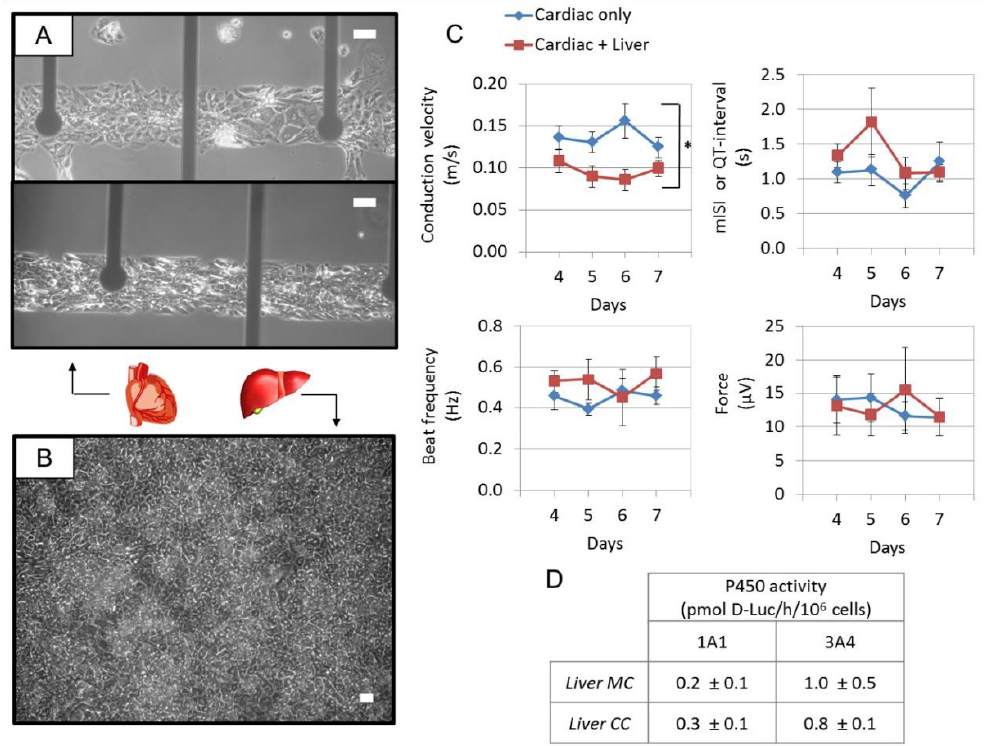
Figure 5. Characterization of the heart–liver system—serum-free and flow—with non-invasive measurements for seven days. Human cardiomyocytes and hepatocytes were studied over seven days in HSL3 medium. Representative morphology images are shown for human cardiomyocytes ( A ) in mono-culture (top) or co-culture (bottom) (80 µ m scale) and hepatocytes in co-culture ( B ) after seven days in the housing (50 µ m scale). Cardiac function was measured over seven days in the presence (red square) or absence (blue diamond) of hepatocytes. Cardiac function is plotted as conduction velocity, spontaneous beat frequency, mISI (or QT interval), and contractile force ( C ). Two-way ANOVA was performed to study the effects of culture time and the presence of the hepatocytes on the different cardiac functional parameters; conduction velocity (p = 0.8, 0.03), beat frequency (p = 0.8, 0.2), mISI (p = 0.3, 0.2) and force (p = 0.7, 0.9). Hepatic function was studied after seven days in the system with cardiomyocytes, and compared to the static mono-culture conditions. No significant differences were evident through a t-test for the 1A1 (p = 0.09) and 3A4 (p = 0.7) enzymes ( D ). For interpretation of the references to color in this Figure legend, the reader is referred to the Web version of this article. Reproduced from [120], with permission from Elsevier, 2018.